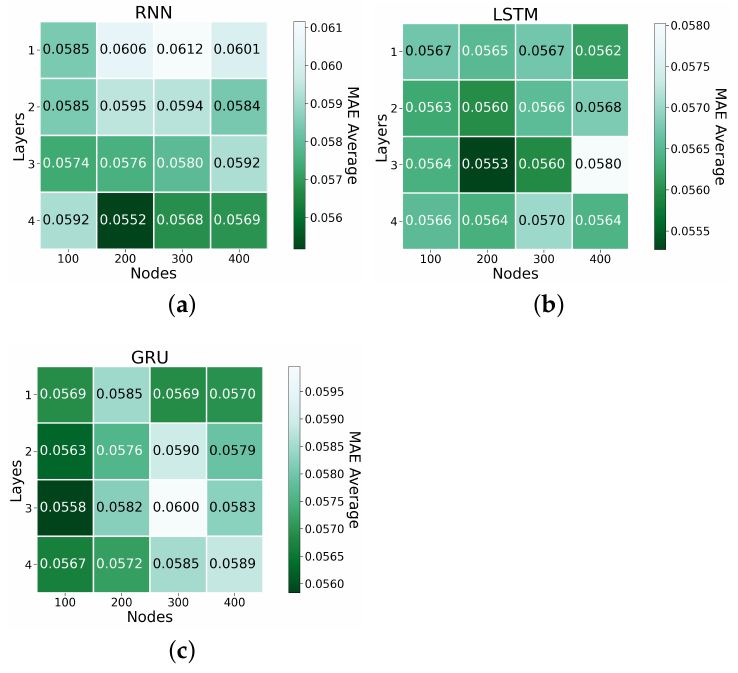
Figure 10. MAE grid search result for ( a ) RNN; ( b ) LSTM; and ( c )